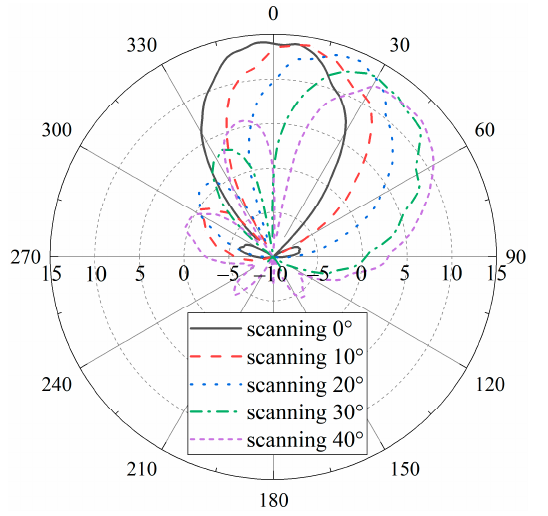
Figure 7. Measured scanning radiation patterns of the NDCPPA model verification prototype.